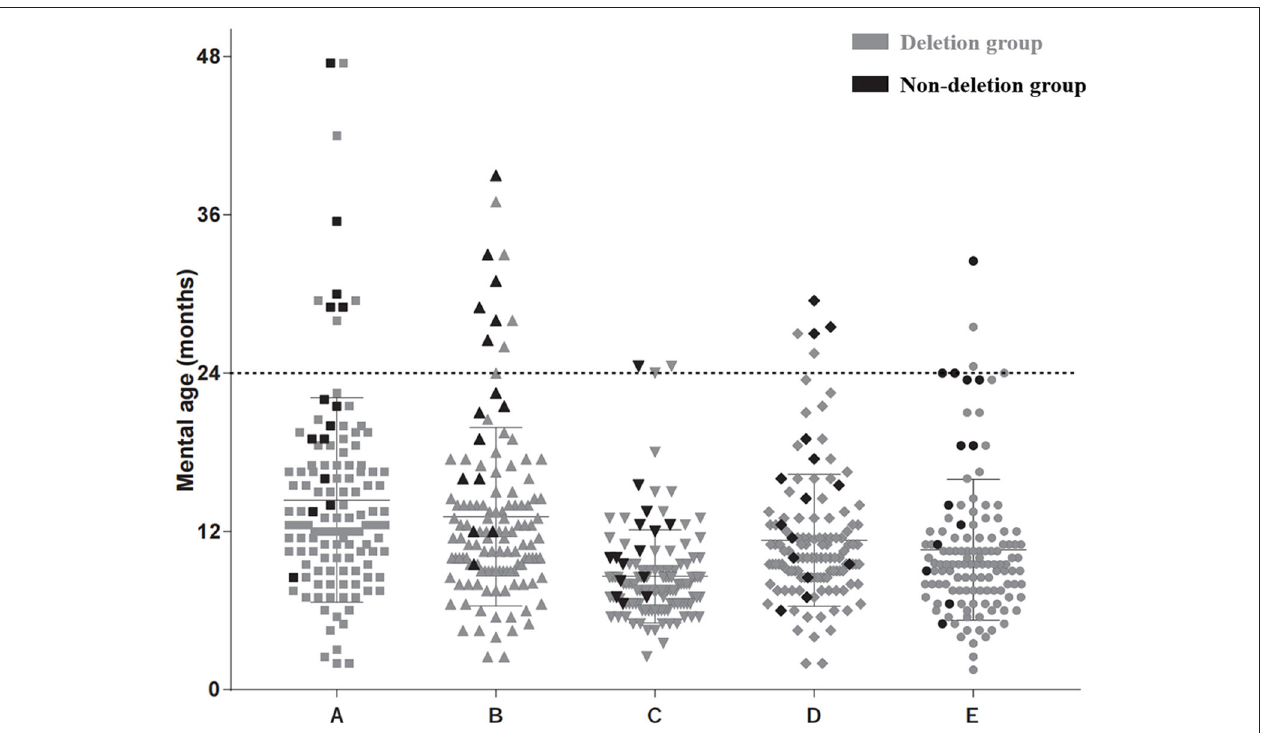
FIGURE 1 | Mental age distribution according to five subscales. (A) Locomotor subscale. (B) Personal-social subscale. (C) Speech and language subscale. (D) Eye-hand coordination subscale. (E) Performance subscale. Each black dot represents one result of the deletion type in this area. Each gray dot represents one result of the non-deletion type.